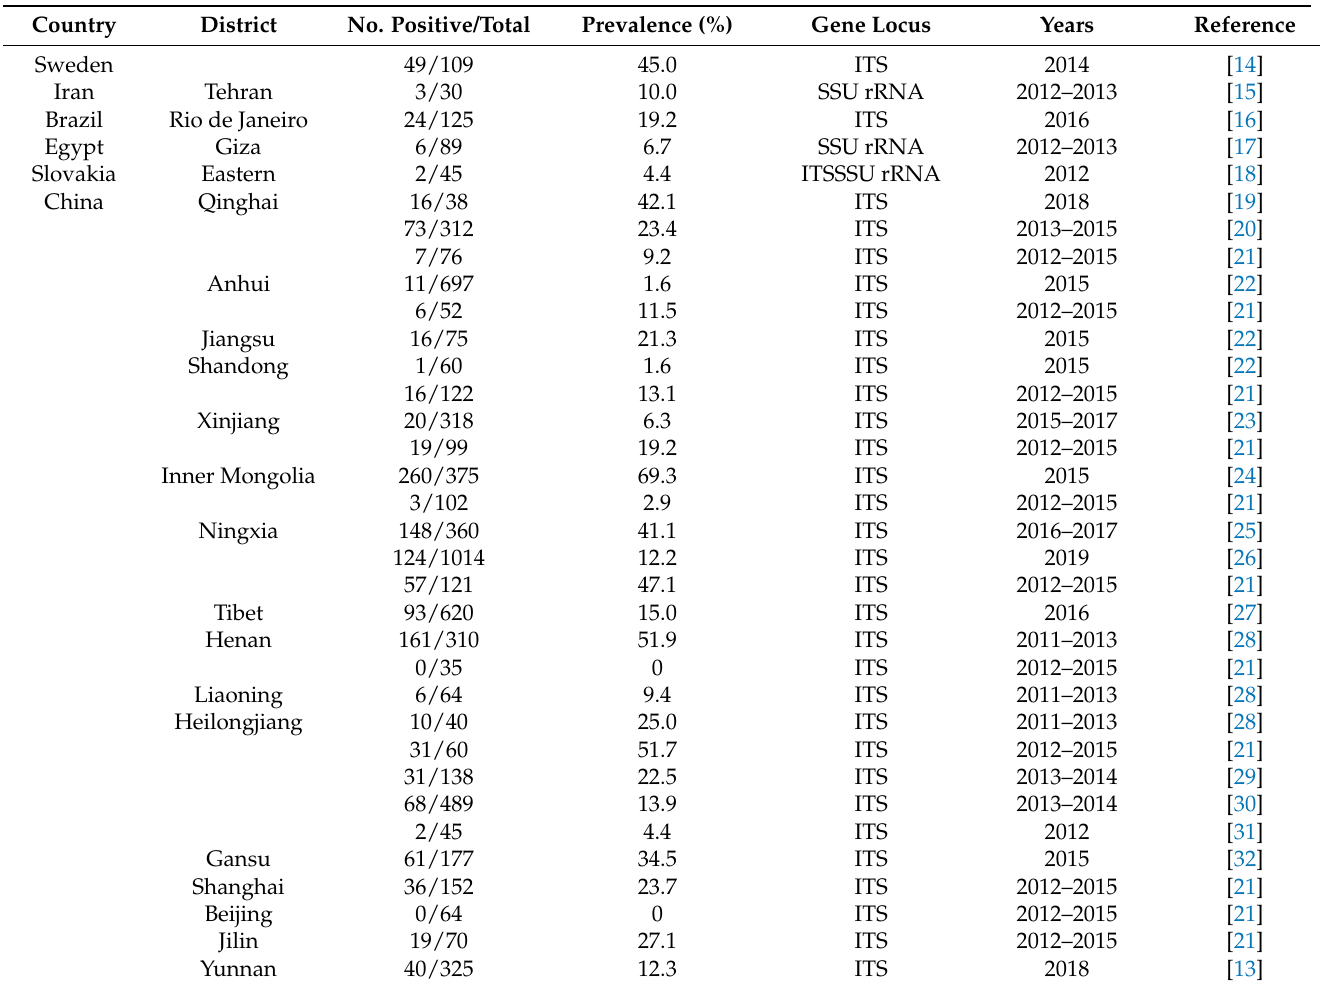
Table 3. Prevalence of Enterocytozoon bieneusi in sheep